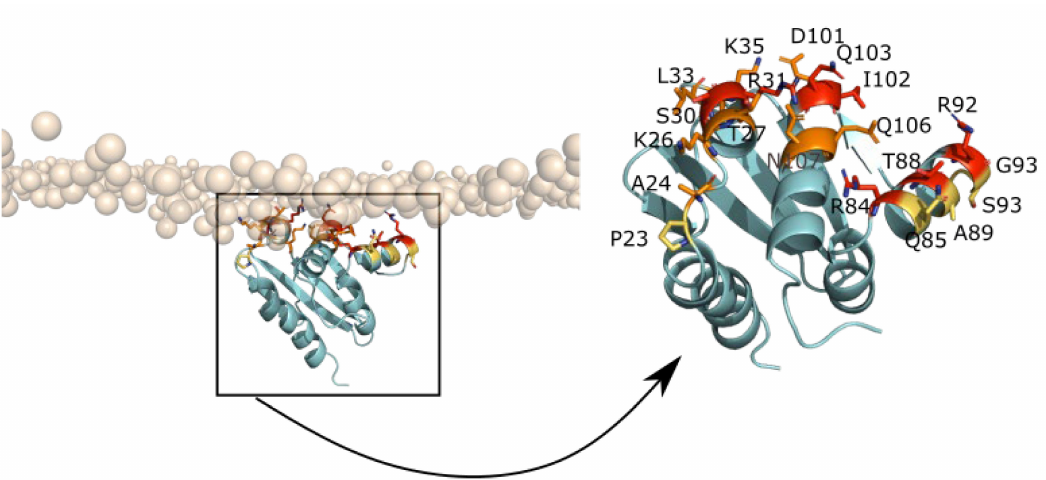
Figure 9. Key residues of UbiJ SCP2 domain in contact with the membrane. On the left, the UbiJ SCP2 domain is shown in cartoon representation and key residues in contact with the membrane in sticks. For clarity, only polar head groups of the membrane are shown in transparent orange spheres. A zoom of only SCP2 domain is shown on the right, with a colour code for residues in contact with the membrane as follows: red for common residues, orange and yellow for specific residues from all-atom and CG simulation,